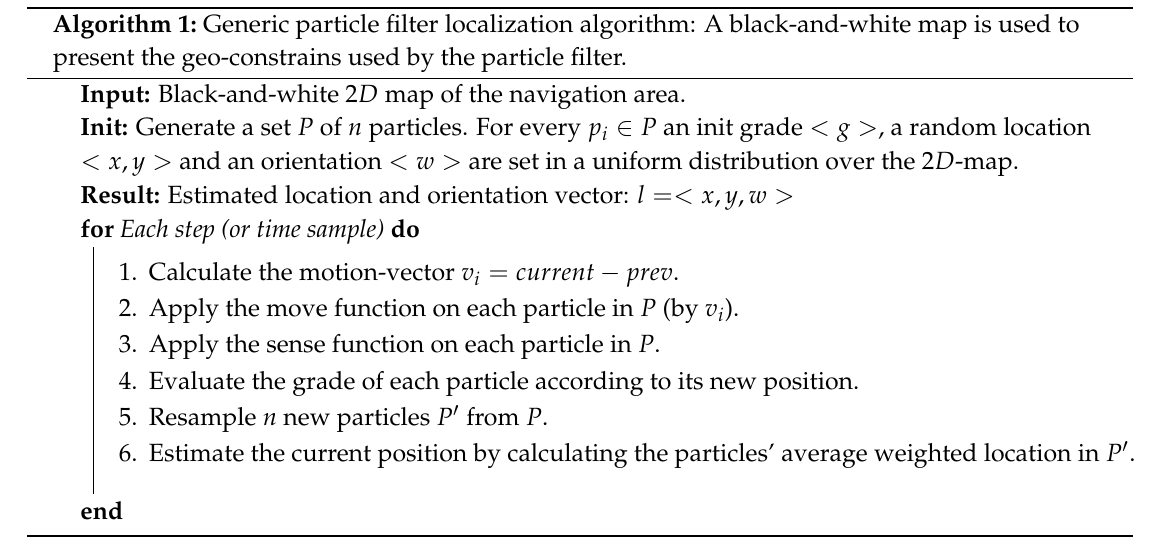
Algorithm 1 and Figure 2 explain the particle filter method process using mobile pedometry sense. Algorithm 1: Generic particle filter localization algorithm: A black-and-white map is used to present the geo-constrains used by the particle